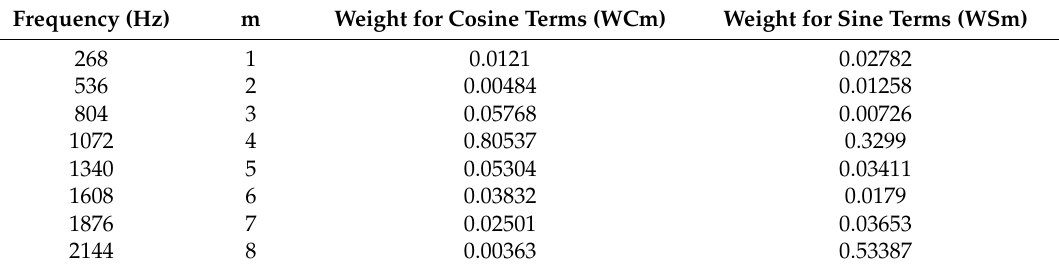
Table 7. The weights at the dominant frequencies